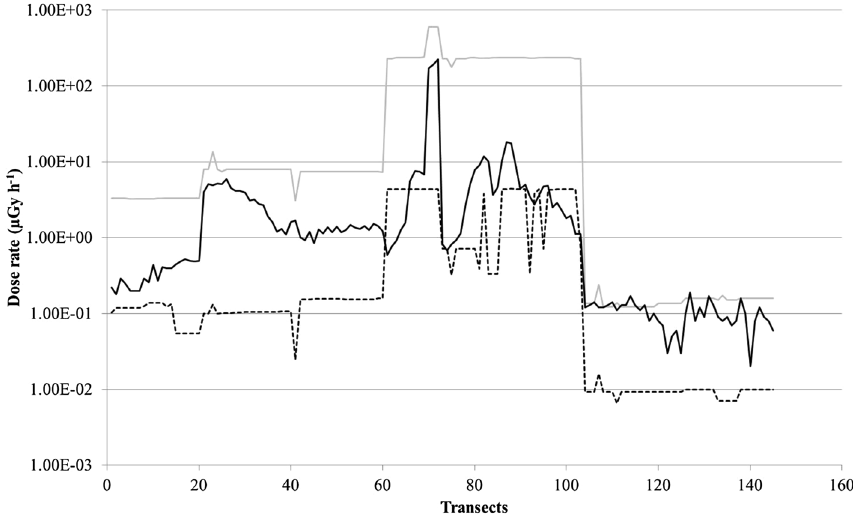
Figure 6. Comparison per transect of the measured ambient dose rate (black line) and the extreme values of dose rate reconstructed for the twelve mammal species (minimal: dot line; maximal: grey line).